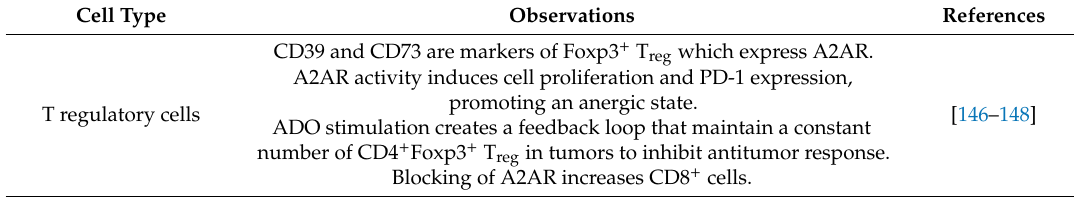
Table 1. Summary of ADO’s actions on immune cells in the TME